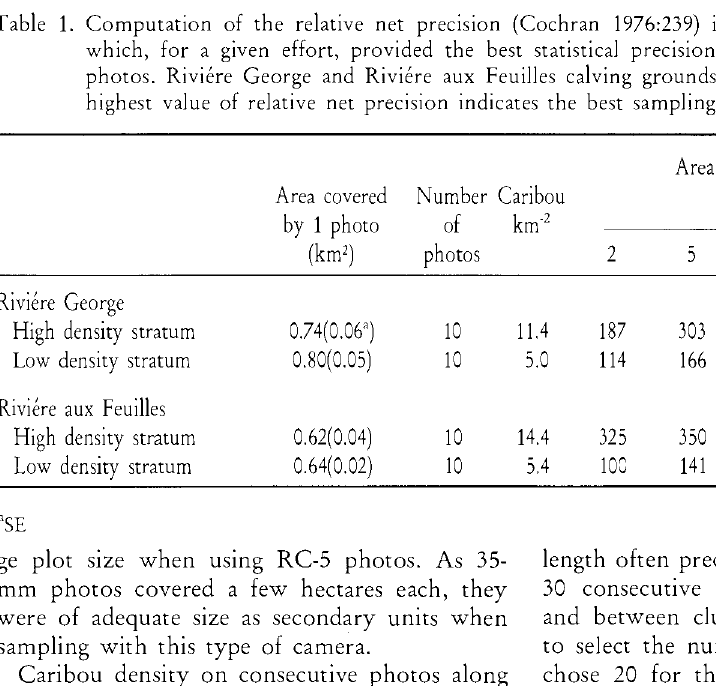
Table 2. Results (F-values) of an analysis of variance for caribou density on aerial photos taken along transect lines and grouped in clusters of 10, 20 or 30 consecutive photos. The model was: density = line cluster (nested in line). When the ratio F-line/F-cluster approaches 1, it indicates that within and be tween cluster variability, is comparable. Photos taken over the Riviere George and Riviere aux Feuil les calving areas between 1984 and 1988 according to 2 density